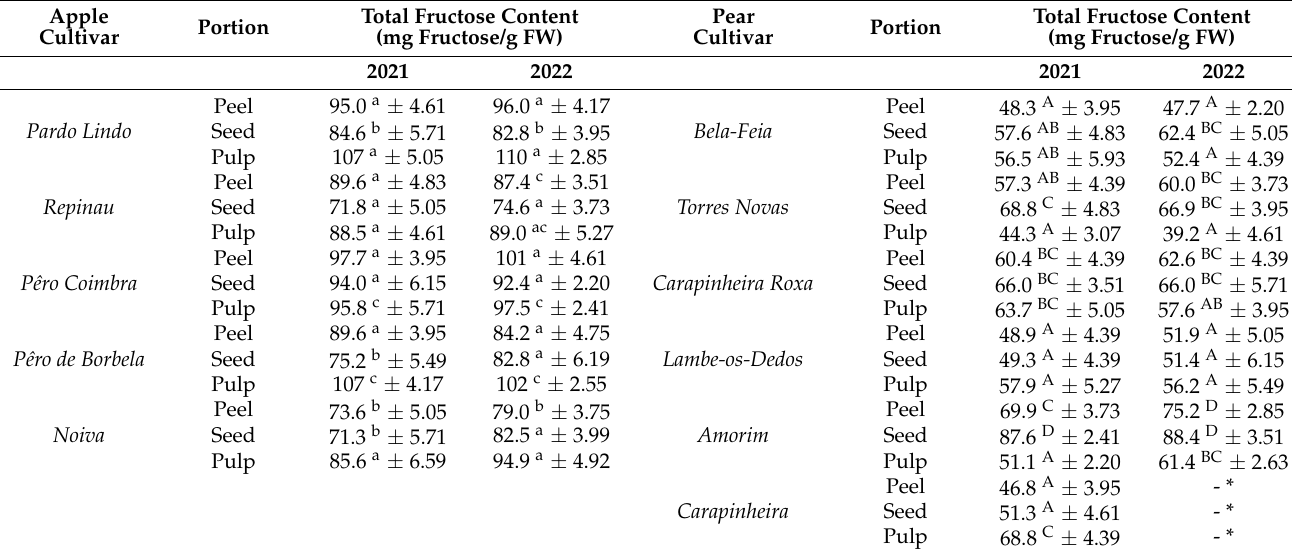
Table 6. Total fructose content of different portions of apple and pear cultivars. Results are expressed in means ± standard